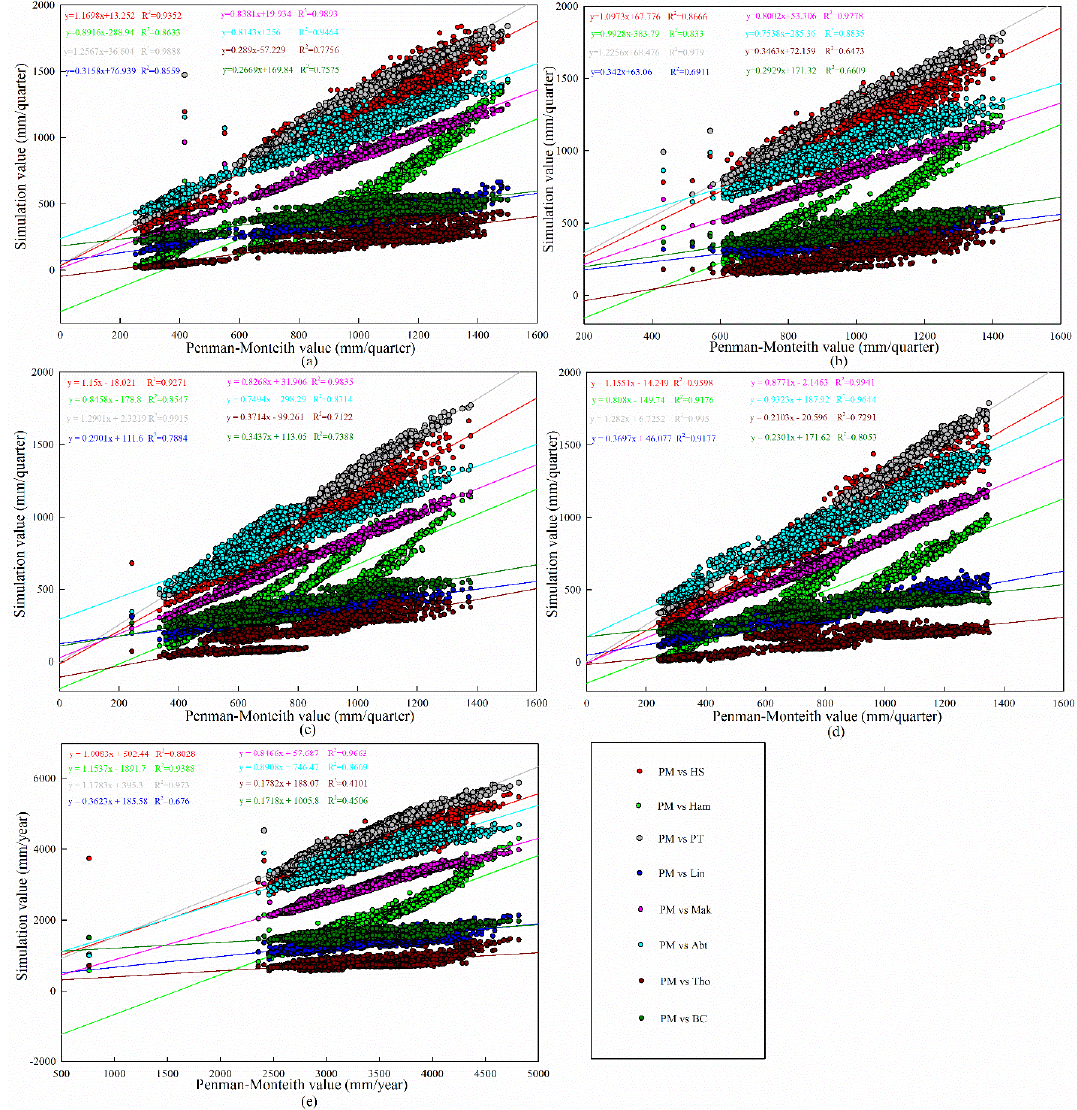
Figure 3. Linear regression of measured and simulation values in the Yun-Gui plateau: ( a ) spring; ( b ) summer; ( c ) autumn; ( d ) winter; and ( e ) annual.